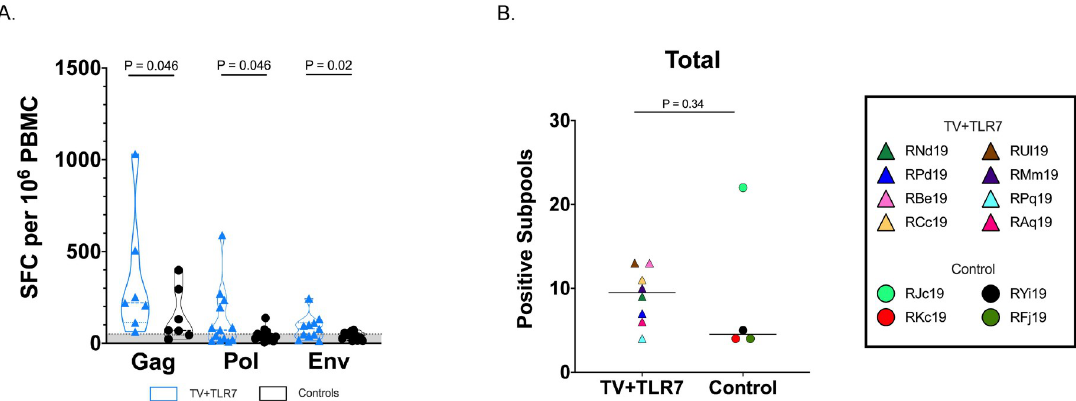
Fig 4. Cellular breadth of immunological response following analytical treatment interruption (ATI) measured by ELISPOT to therapeutic vaccination in SIV-infected, ART-treated infant RMs. (A) IFN- γ ELISPOT responses to 10-mer peptide subpools spanning the Gag, Pol, and Env proteins from SIV mac239 following ATI in TV+TLR7 RMs and control RMs. Bars represent median ± quartiles and the gray shading bordered by the horizontal dashed line represents the limit of detection. Statistical analysis was performed using Wilcoxon matched-pairs signed rank tests. SFC, spot forming cells. (B) Cellular immune breadth in TV+TLR7 RMs and control RMs as measured by total positive subpools of 10 peptides spanning the SIV mac239 Gag, Pol, and Env proteins following ATI. Black bar represents median. Groups were compared using a two-sided Mann-Whitney test (P < 0.05 was considered significant).